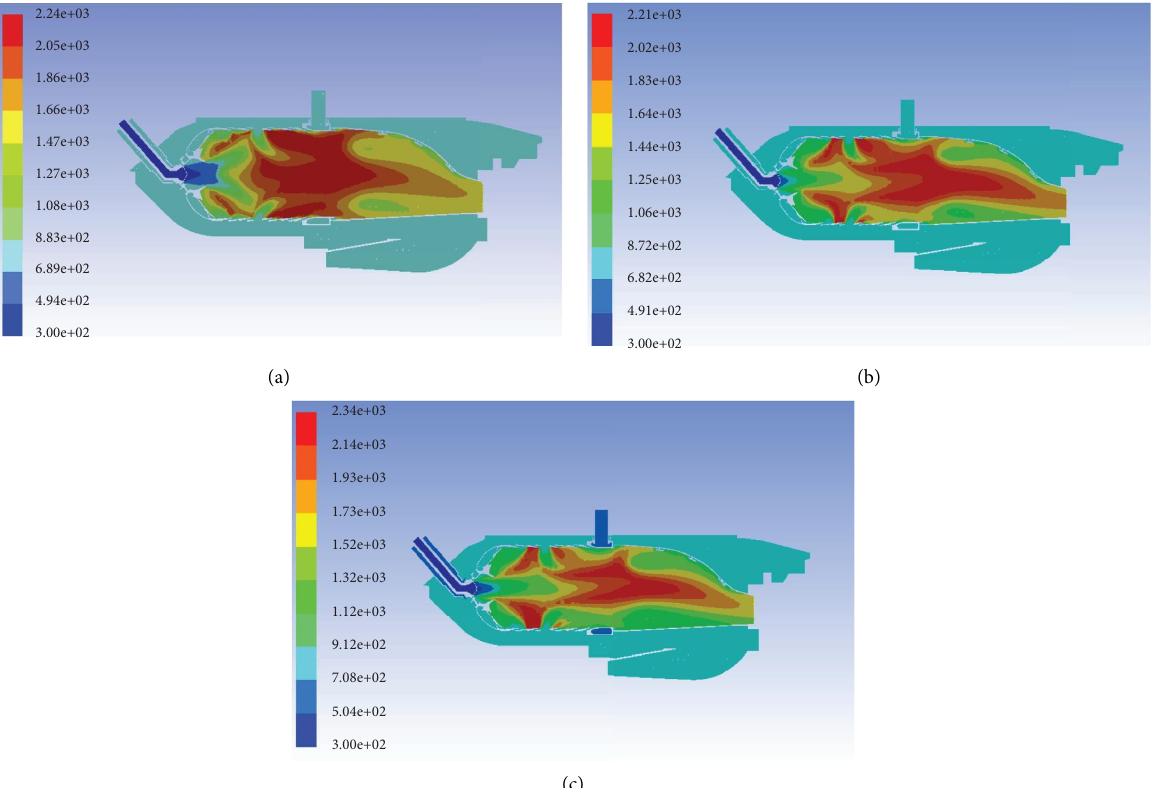
Figure 7: Contours of temperature (K), inside a combustion chamber for diferent volume content of hydrogen in the mixture: 0 (a), 50% (b), 100%